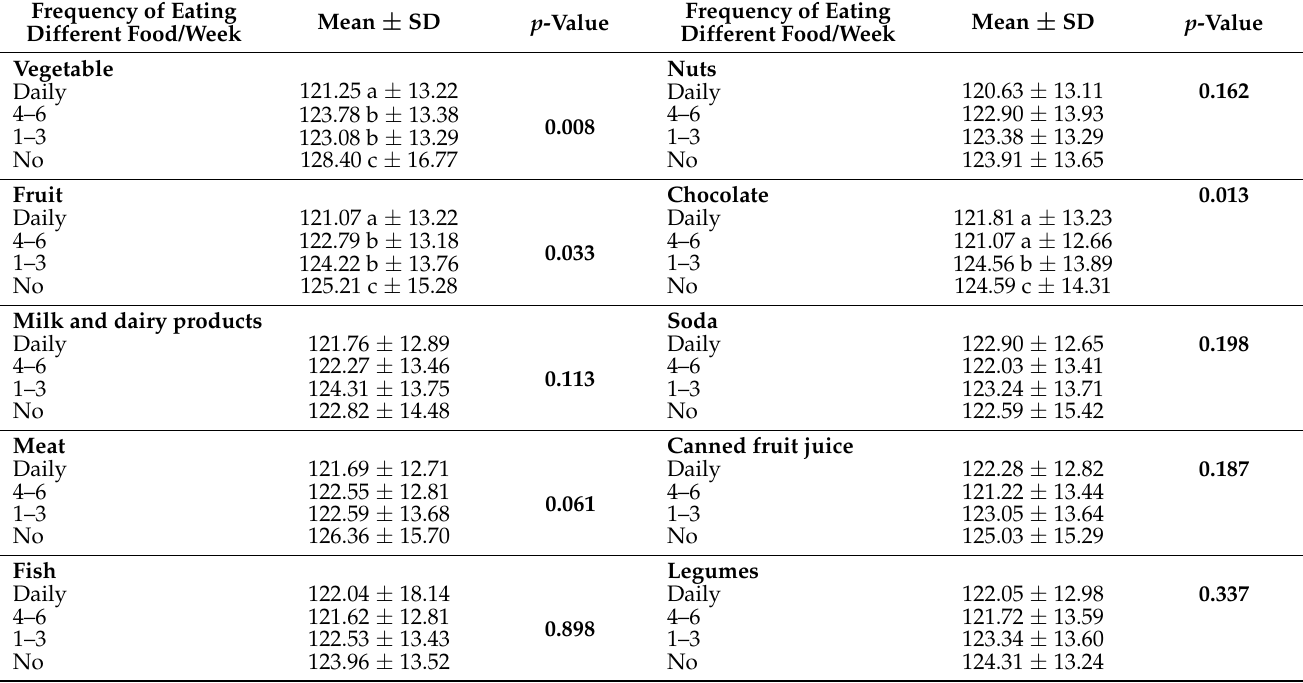
Table 2. Prevalence of hypertension according to adolescents food group